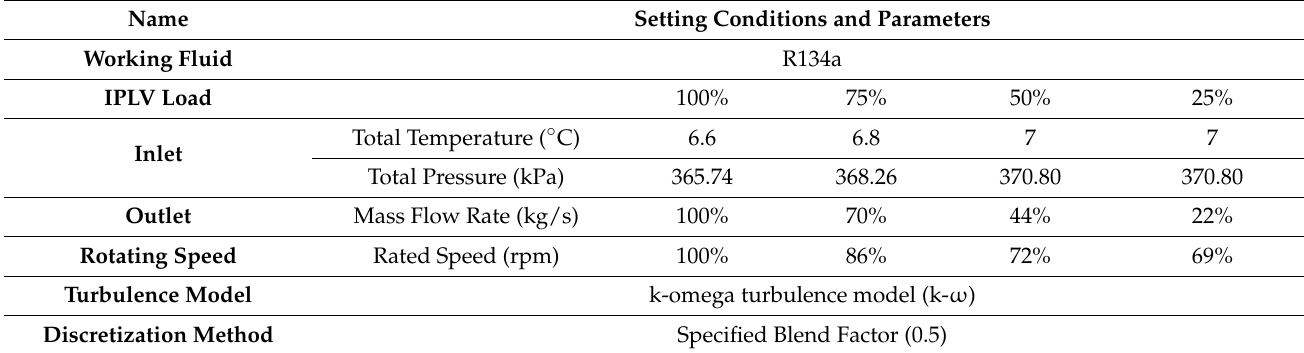
Table 5. Description of boundary condition and parameter setting